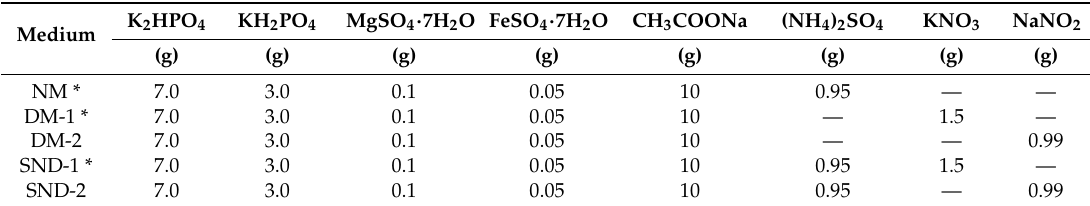
Table 1. The ingredients of inorganic medium in 1 L ultrapure